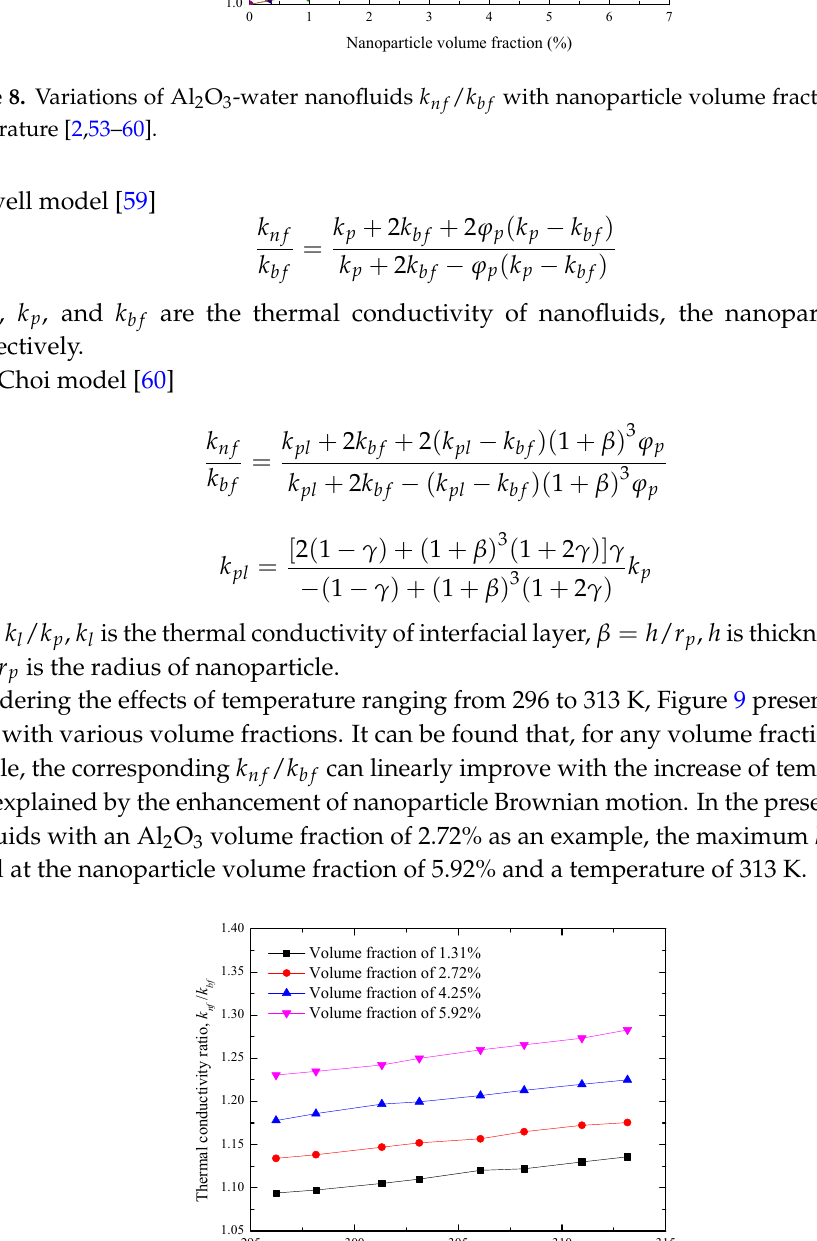
Figure 9. Variations of k nf / k bf with temperature for different nanoparticle volume fractions of Al 2 O 3 -water nanofluids.